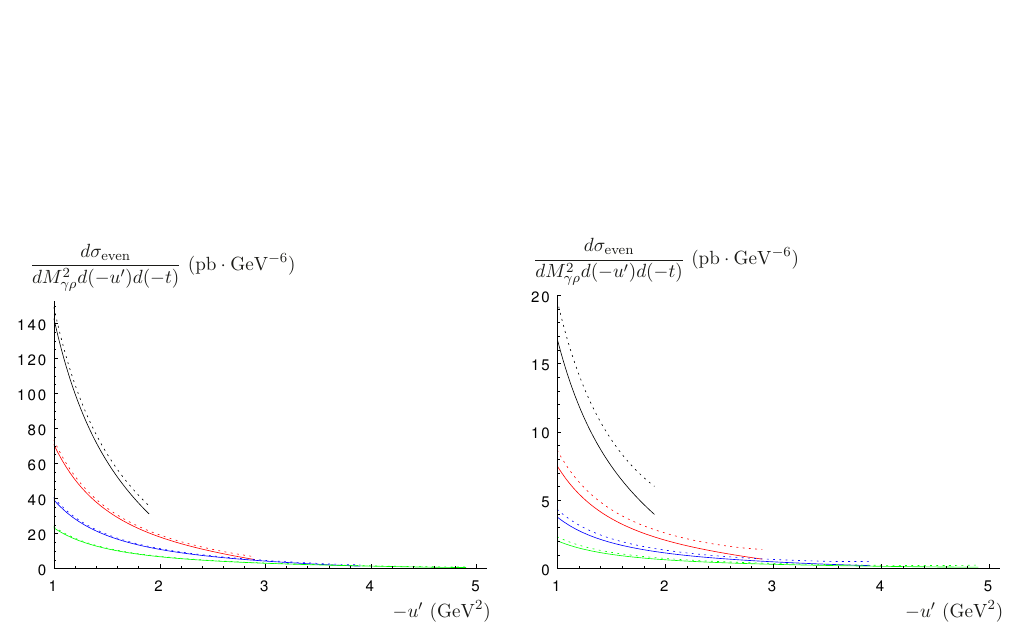
Figure 8 . Differential cross section for a photon and a longitudinally polarized ρ meson production, for the proton (left) and the neutron (right), as a function of − u ′ , for M 2 curves differ with respect to the ans¨atze for the PDFs q , and thus for the GPDs H u and H d : GRV-98 (solid black), MSTW2008lo (long-dashed blue), MSTW2008nnlo (short-dashed red), ABM11nnlo (dotted-dashed green), CT10nnlo (dotted brown).